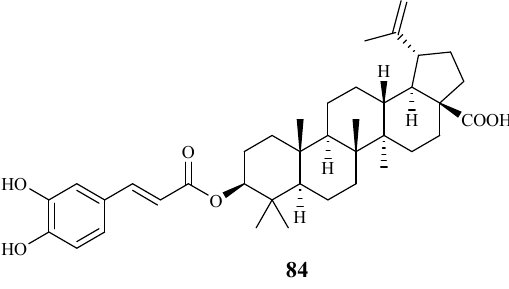
Figure 15. Compounds from an Ebenaceae plant.